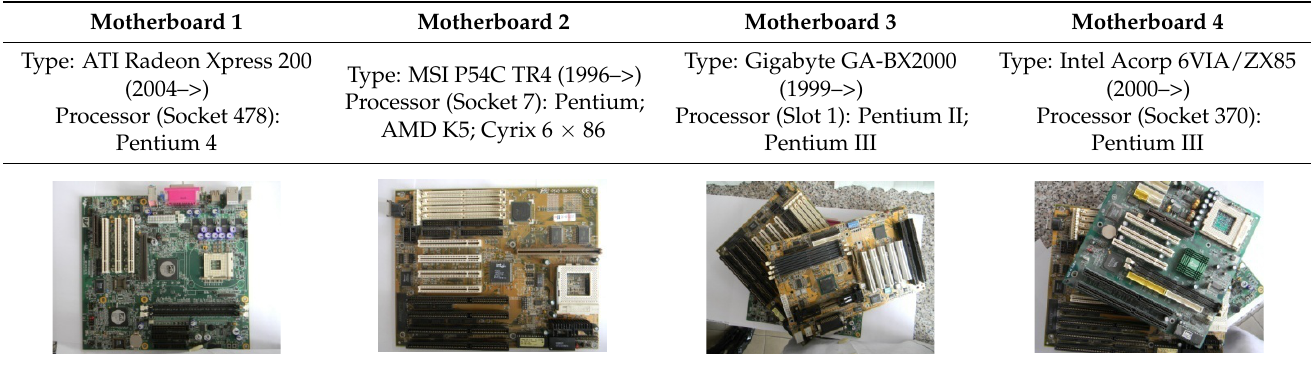
Table 1. WPCBs samples used in the experimental studies.